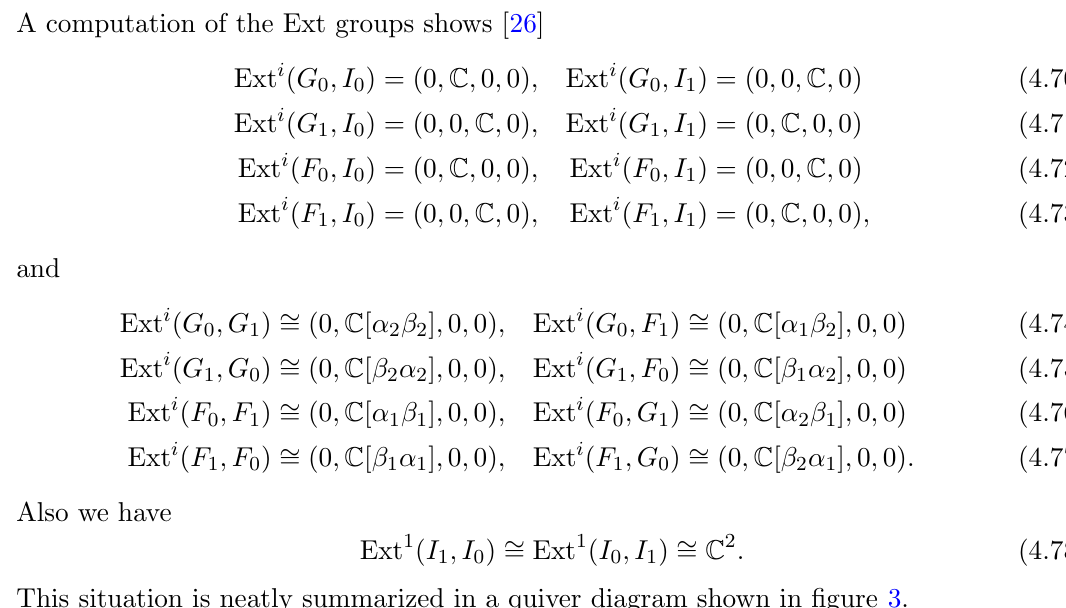
Figure 3 . Quiver theory for GUT and (cid:13)avor branes. Note that one should draw F 1 separately and connect to the other nodes as indicated. For the sake of clarity only one (cid:13)avor brane/image brane is